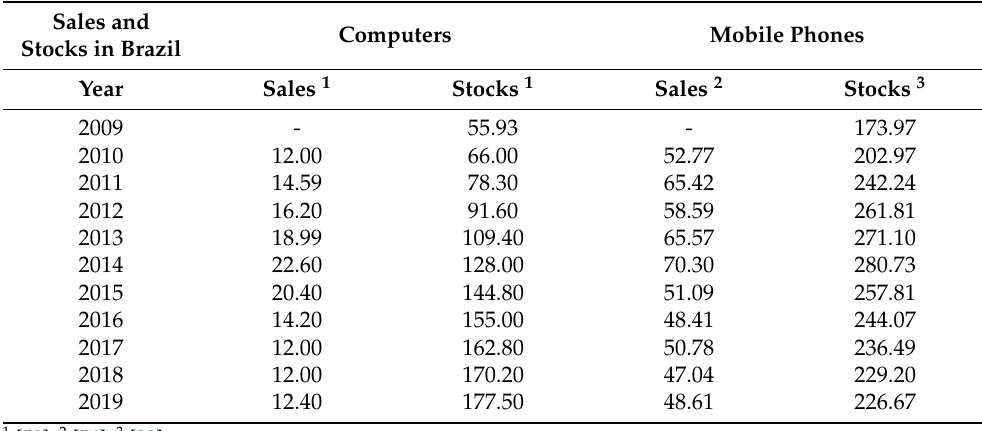
Table A1. HDDs (computers) and MPs sales and stocks from 2009 to 2019 in Brazil (million units).